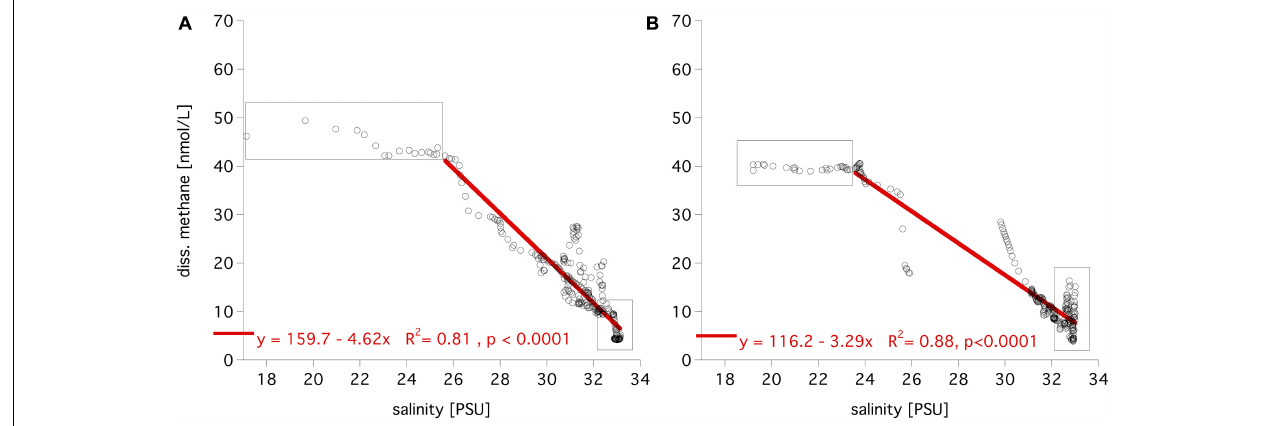
FIGURE 3 | Dilution of river water with marine water on 26 June (A) with Weser water and (B) with Elbe water. The boxes indicate the riverine and marine part. The red line indicates the regression line and its equation.